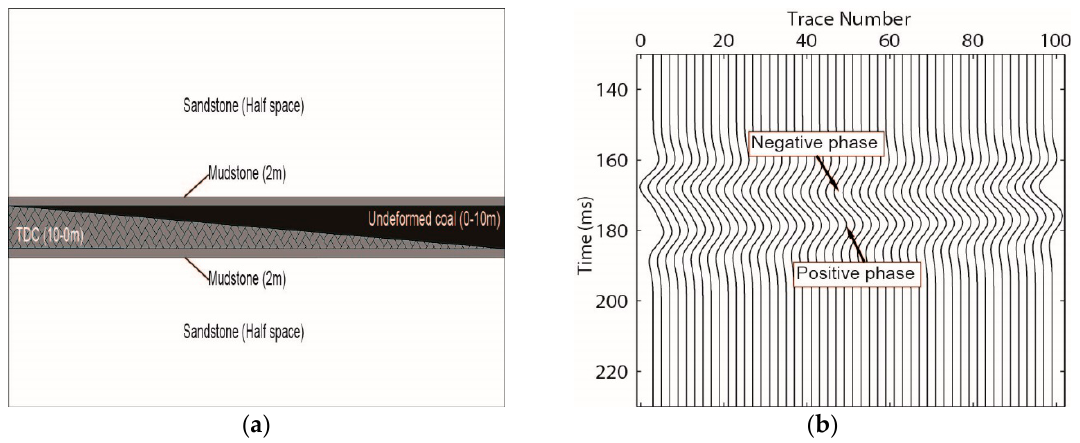
Figure 3. A geological coalbed model ( a ), and its corresponding synthetic seismic section ( b ).